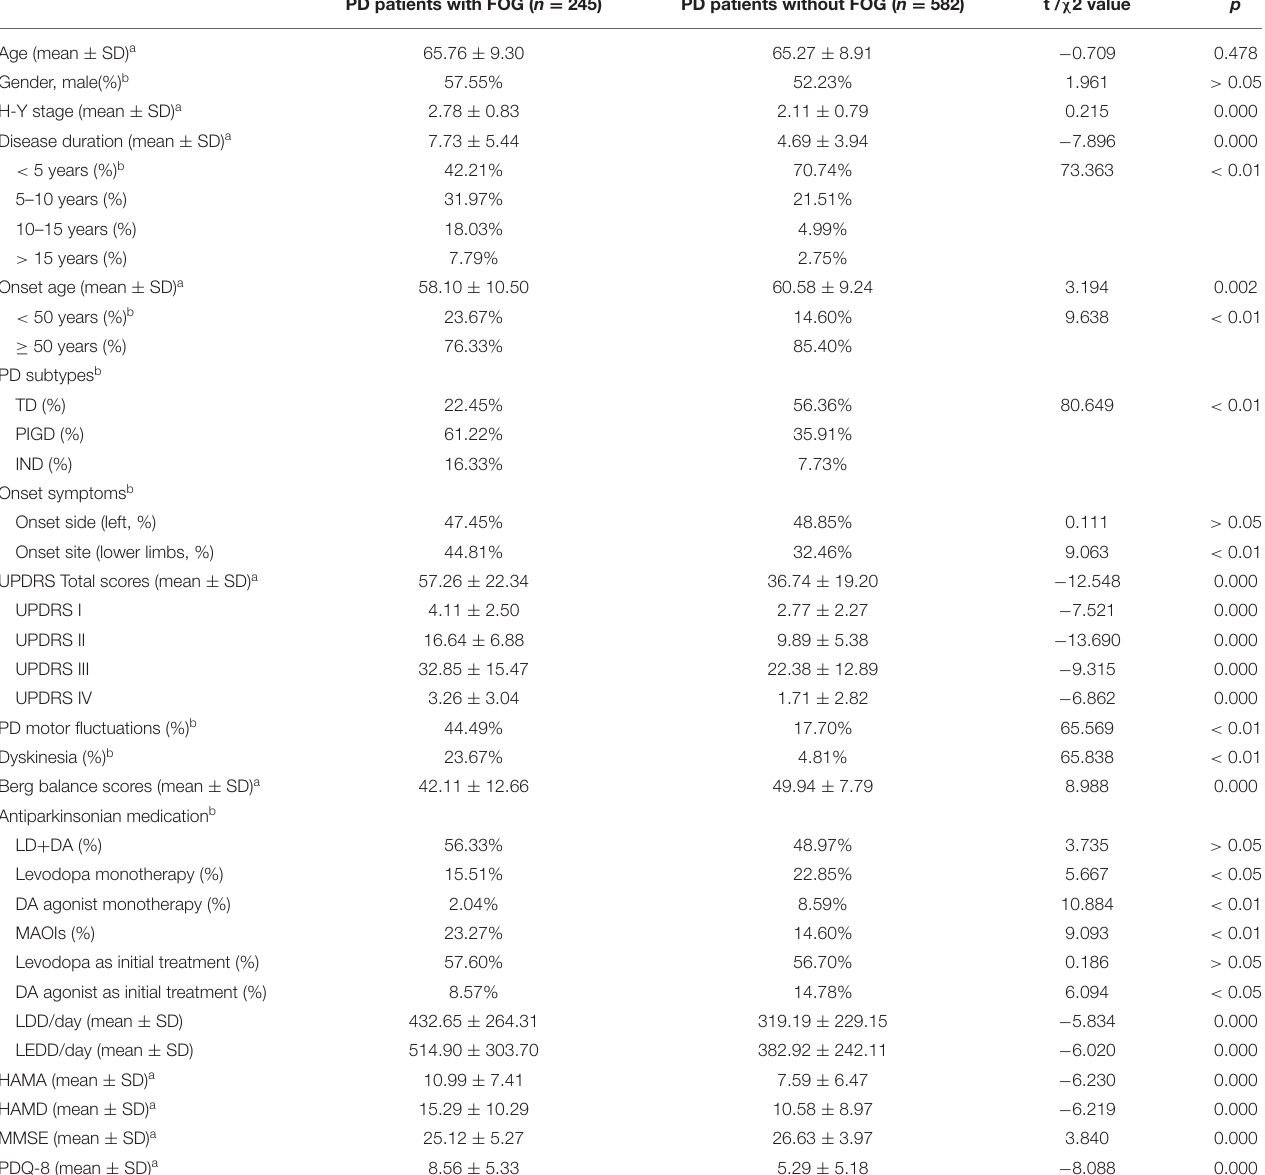
TABLE 1 | Demographic details of PD patients with or without FOG in this study. PD patients with FOG ( n = 245) PD patients without FOG ( n =